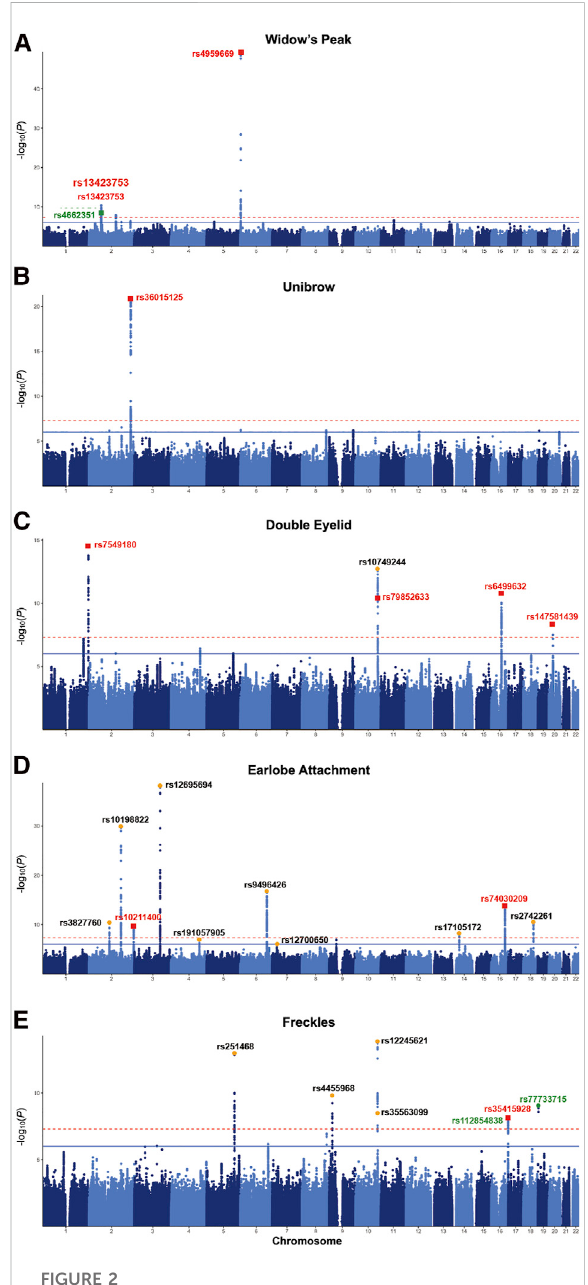
FIGURE 2 Manhattan plots of the discovery GWAS. Manhattan plot for (A) widow ’ s peak; (B) unibrow; (C) double eyelid; (D) earlobe attachment; (E) freckles. Bonferroni corrected threshold and candidate threshold correspond to 7.30 and 5.30, respectively, with regard to − log 10 ( P ). Previously unreported SNPs are marked RED, previously reported SNPs are dotted ORANGE, and the SNPs failing validation are marked GREEN. GWAS, genome-wide association study. SNP, single nucleotide